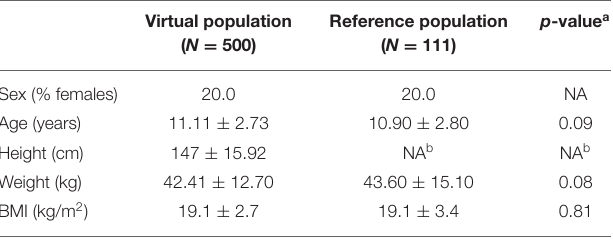
TABLE 5 | Demographic characteristics of the pediatric-adolescent virtual population and the reference population. Virtual population ( N =